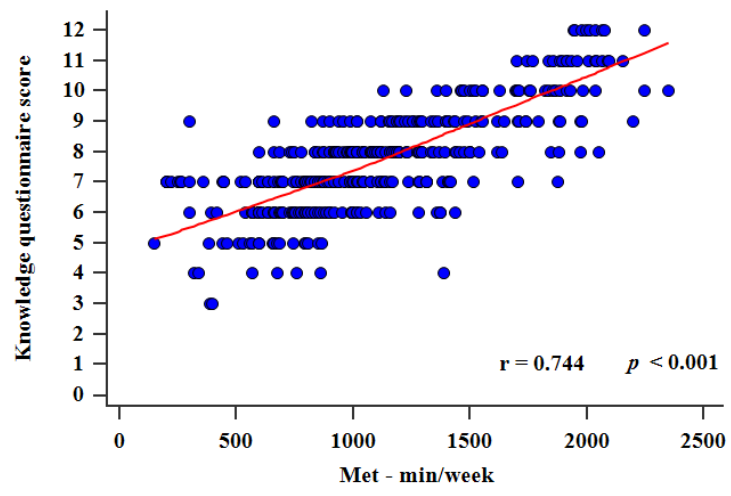
Figure 2. Correlation between total MET scores and knowledge questionnaire score (0–12). Table 5. Multiple linear regression model of independent predictors for knowledge questionnaire results.